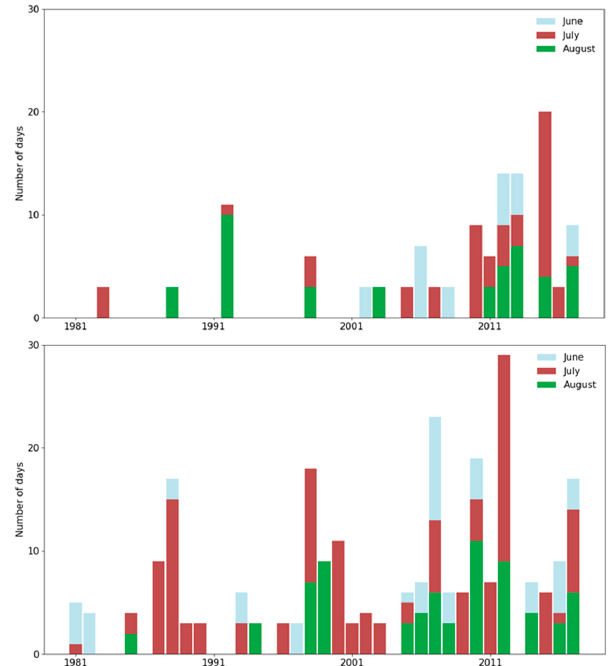
Figure 2. The annual number (divided monthly by colors) of days in heat waves in the period 1981–2017 in Brnik (Slovenia; top) and Larisa (Greece; bottom).